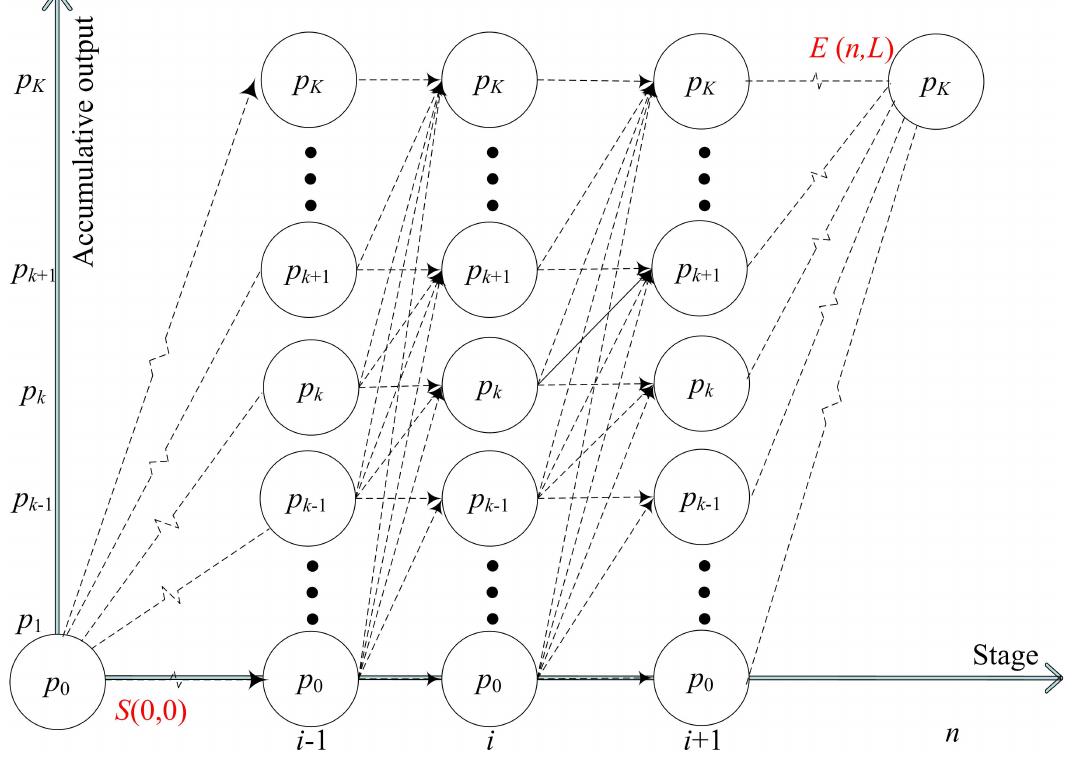
Figure 3. The discretized OLD is equivalent to a shortest path problem for finding an optimal path from the origin (0 , 0) to the point ( n, L ) that passes through the points on the